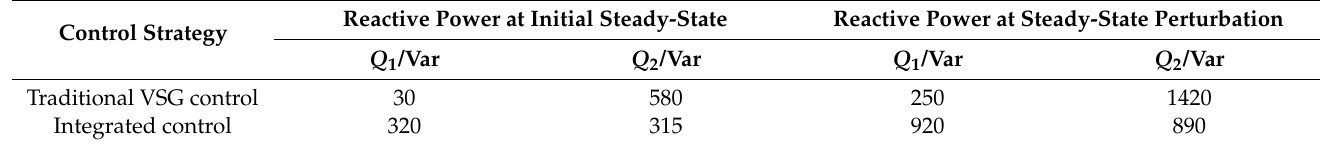
Figure 9. Waveforms of the experimental results using different control strategies in experimental condition 1. ( a ) The traditional VSG control strategy outputs power waveform. ( b ) The traditional VSG control strategy outputs the voltage effective value of U PCCa and circulation waveform. ( c ) The integrated control strategy presented in this study outputs power waveform. ( d ) The integrated control strategy presented in this study outputs the voltage effective value of U PCCa and circulation waveform. Table 5. Steady-state values of reactive power with the same